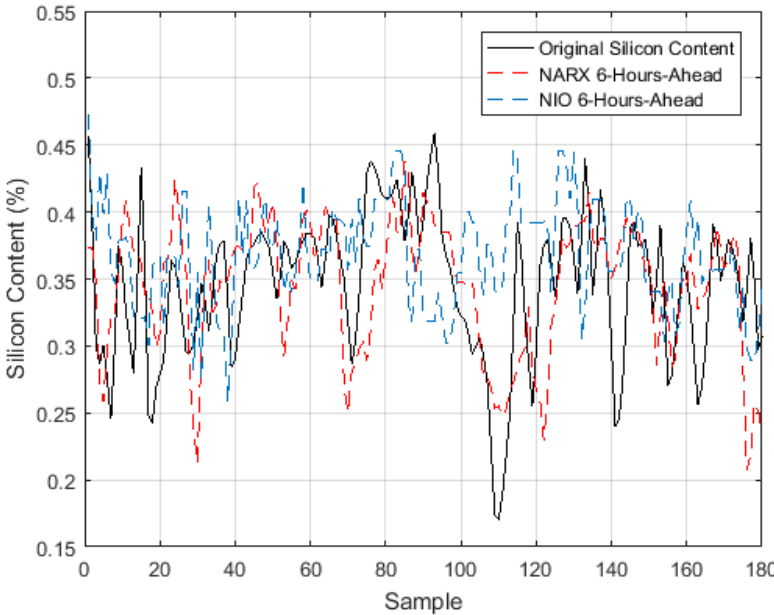
Figure 6. Silicon content and its six-hour-ahead forecasts from the NIO and NARX models.